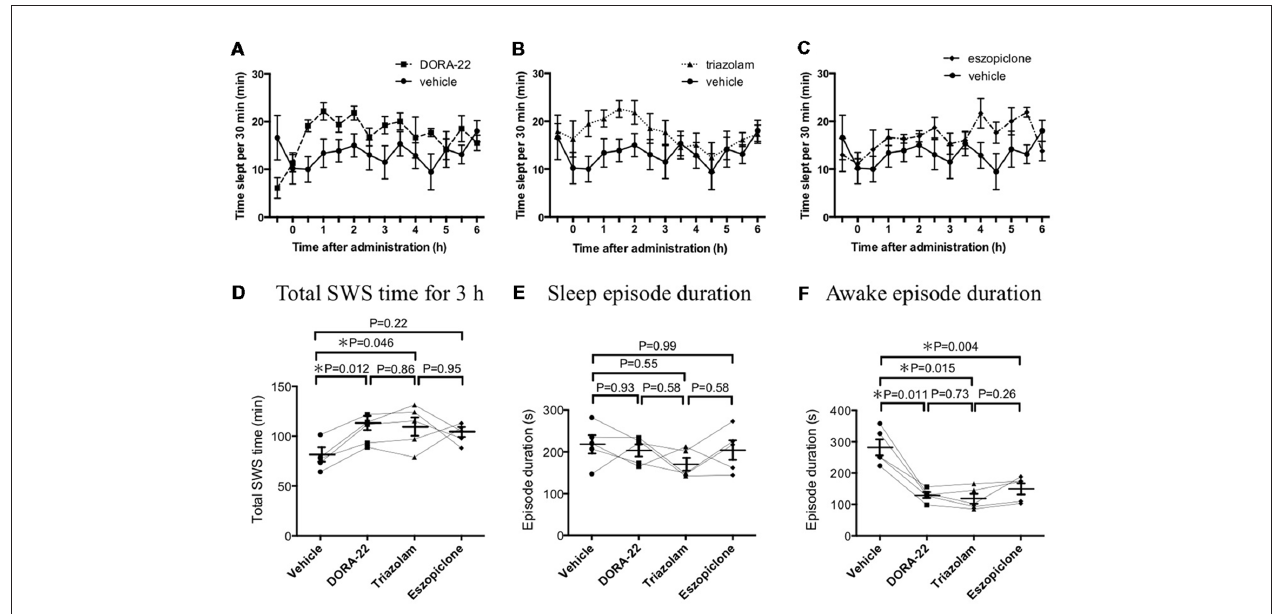
FIGURE 1 | Effects of dual orexin receptor antagonist-22 (DORA-22), triazolam, and eszopiclone on sleep time and sleep architecture. Time slept per every 30 min is shown for (A) DORA-22, (B) triazolam, and (C) eszopiclone for 6 h after p.o. administration of the drugs. The same values for the vehicle are shown repeatedly for comparison purposes. Each animal received DORA, triazolam, eszopiclone, and vehicle in a randomized order on spaced days. Data are shown as Mean ± SEM. (D) Comparison among the four treatments ( F ( 3,12 ) = 5.101, p = 0.017) revealed that DORA-22 and triazolam, but not eszopiclone, significantly increased total sleep time during a 3-h period starting at 1 h after administration. These drugs did not affect sleep episode duration ( F ( 3,12 ) = 0.906, p = 0.467; E ) but did decrease awake episode duration ( F ( 3,12 ) = 33.0, p < 0.001; F ). In (D–F) , data from the same animal are connected with lines to show possible interactions between drugs in individual mice. Horizontal lines indicate mean value for each treatment. Statistical results using repeated measure ANOVA followed by Tukey’s multiple comparisons test are indicated in the graph.